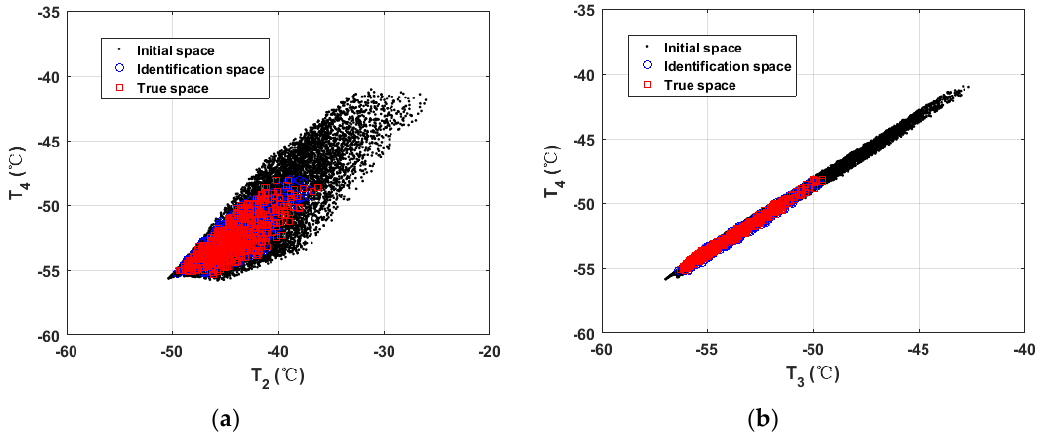
Figure 12. The initial, true, and identification space in the heat transfer system: ( a ) Temperature response T 2 –T 4 ; ( b ) Temperature response T 3 –T 4 .